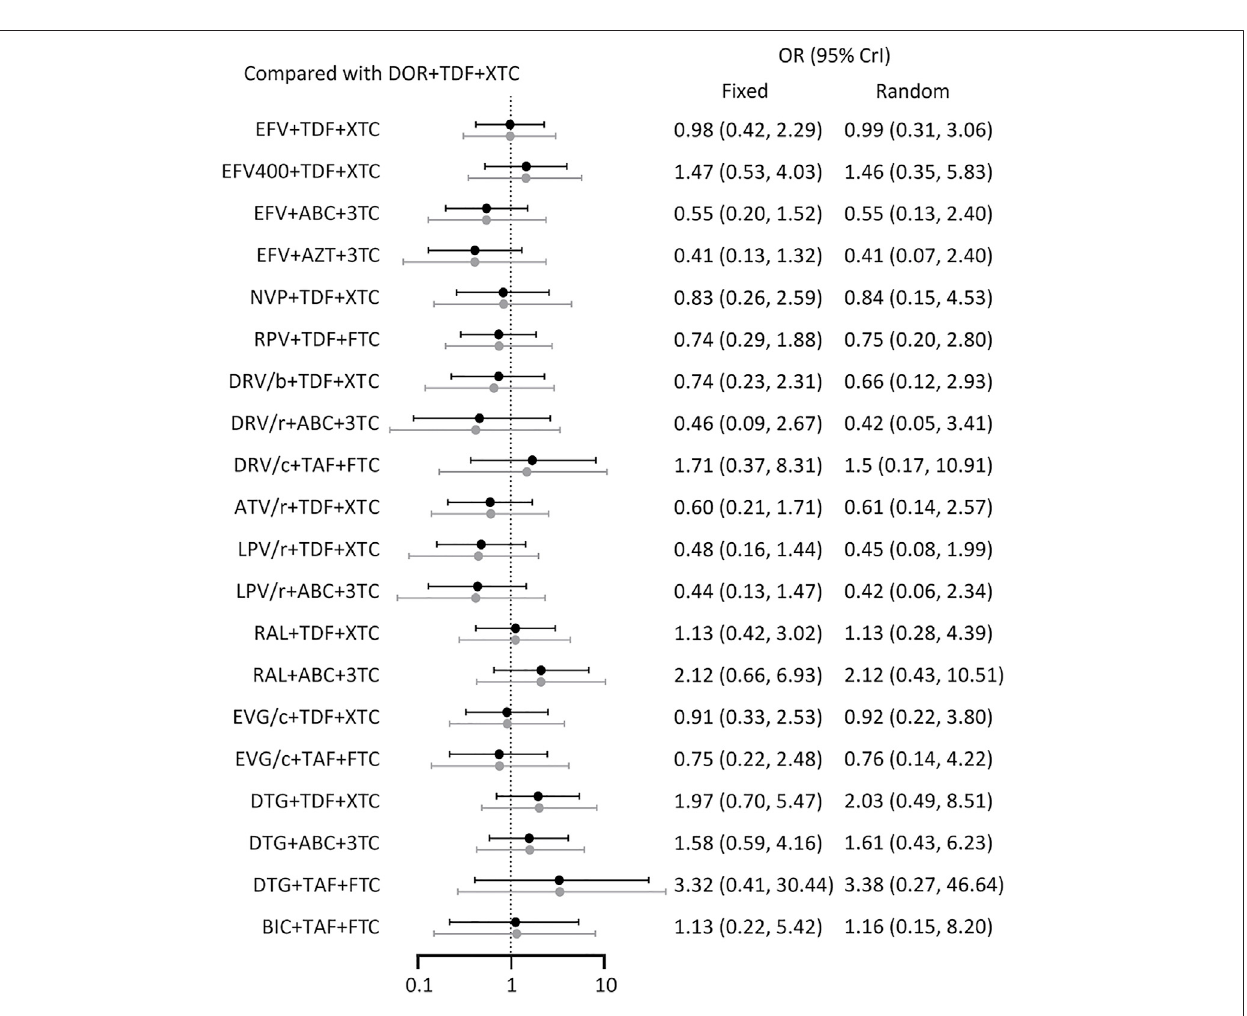
Frontiers in Pharmacology |